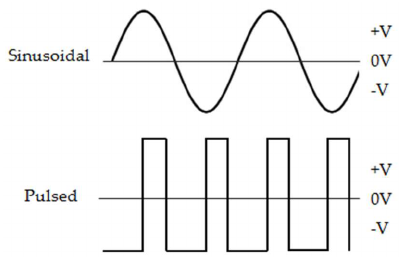
Figure 8. Schematic representation of the waveforms of the extremely low-frequency EMFs. PEMF parameters were 0.3 ms width duration, 12 Hz frequency, and 142 mV curve amplitude, SEMF parameters were 50 Hz frequency and 42 mV curve amplitude, and both EMFs had a flux density of 1 mT (rms).